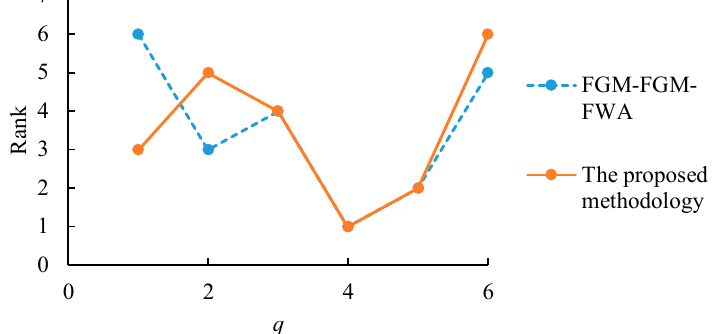
Figure 8. Comparison of the ranking results.